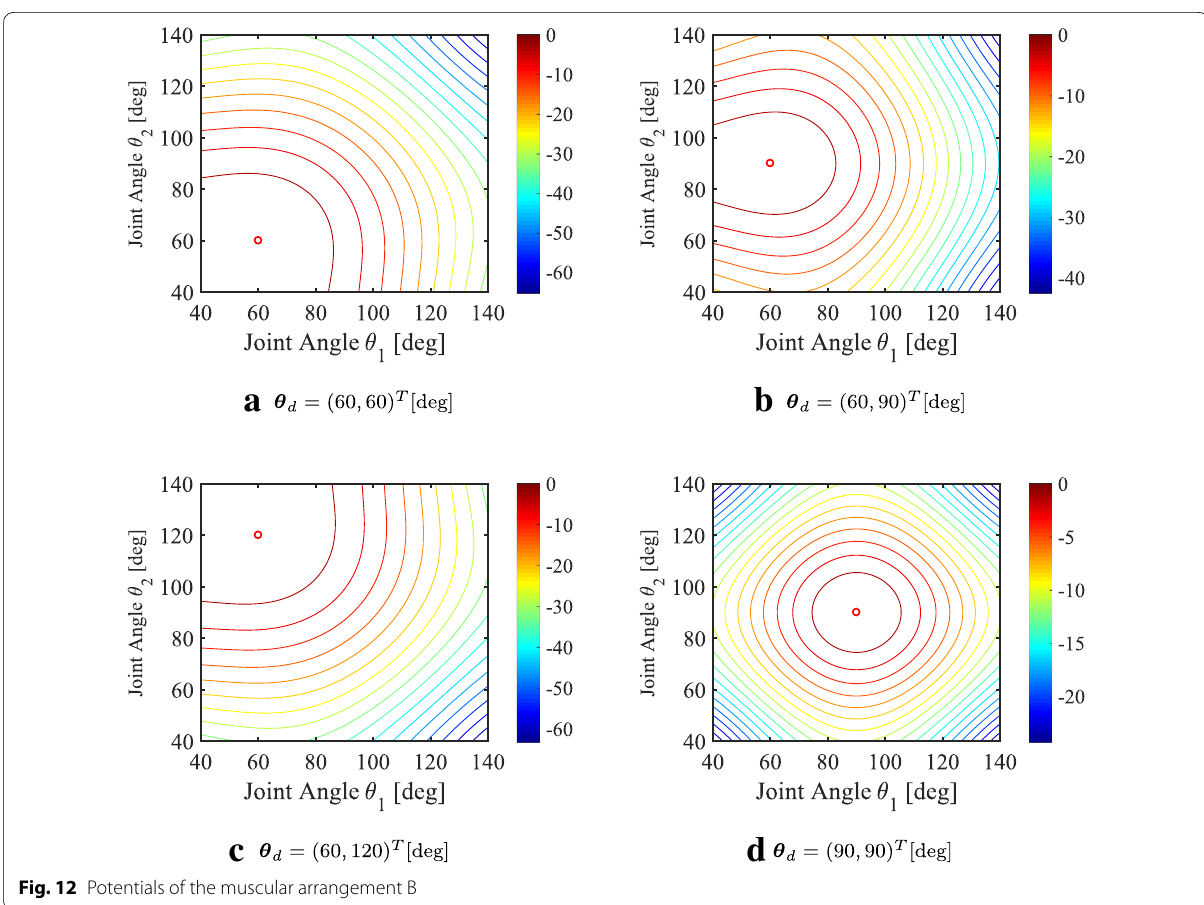
Fig. 12 Potentials of the muscular arrangement